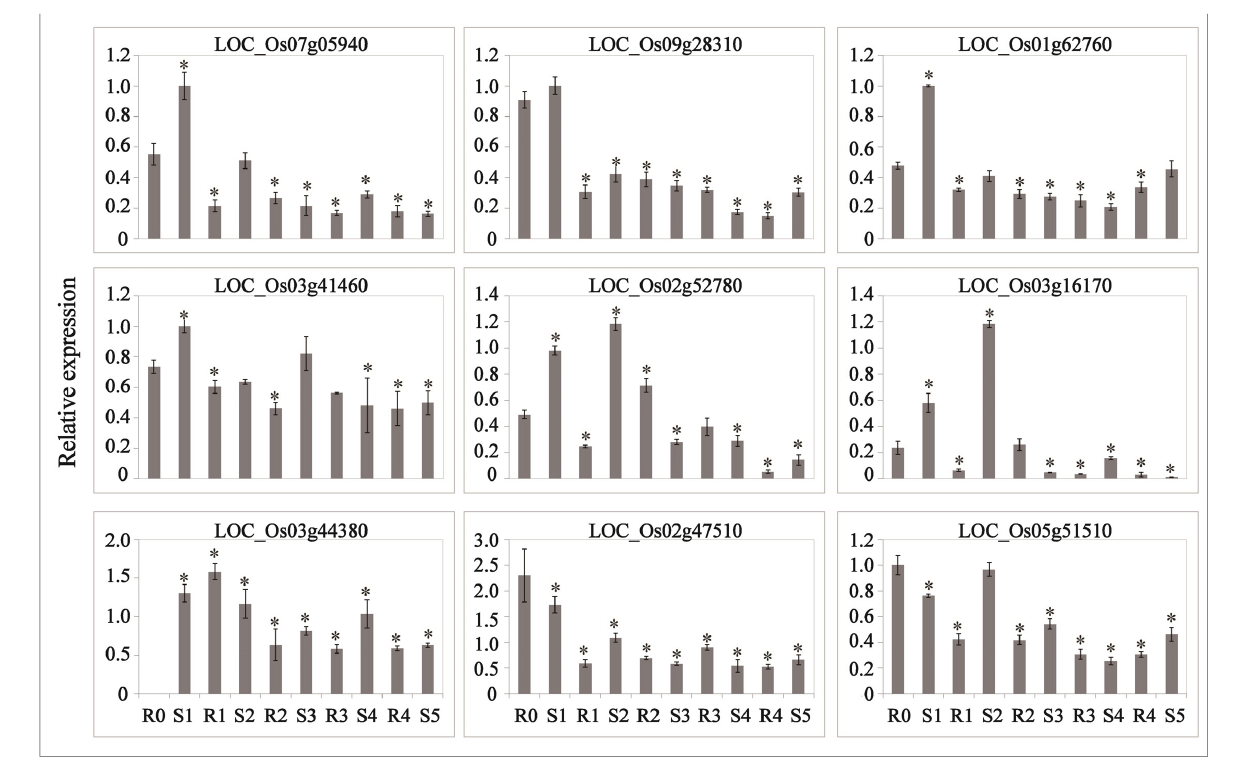
FIGURE 4 | Real-time quantitative PCR analysis for stress memory transcripts involved in ABA metabolism and signaling pathways during the drought stress cycles. EF-1 α (LOC_Os03g08020) was used as an internal control. Data are means of three biological replicates and error bars are ± SE from three independent experiments, each performed with 6–8 leaves from five separate plants. Asterisks indicate significant differences by Tukey LSD test ( ∗ P < 0.05).